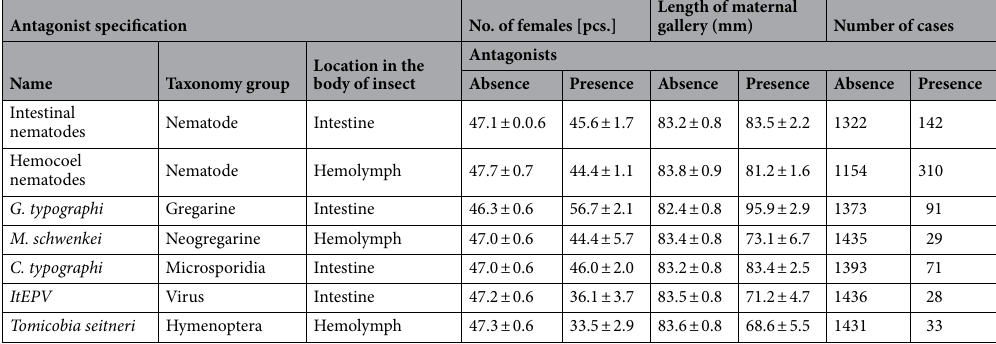
Table 2. Basic statistics (mean ± SE) of gallery pattern and number of I. typographus females in relation to presence or absence of antagonists of selected taxonomic